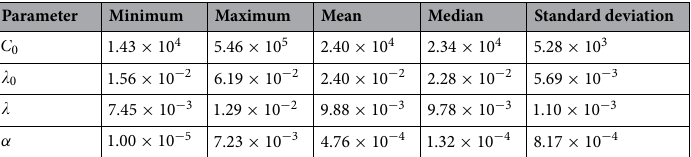
the parameter α , and is estimated to be low for both models and clonotypes, suggesting that cell death does not have a significant impact on the dynamics during lymphopenia, which is in fact dominated by cell division. This result is in agreement with Hogan et al. 20 , where the death rate is assumed to be zero. The initial number of cells can be estimated with relative success, and does not seem to depend heavily on the model considered. On the other hand, cell division is governed by parameters ( N 0 , (cid:31) 0 , N , (cid:31) ) , with N 0